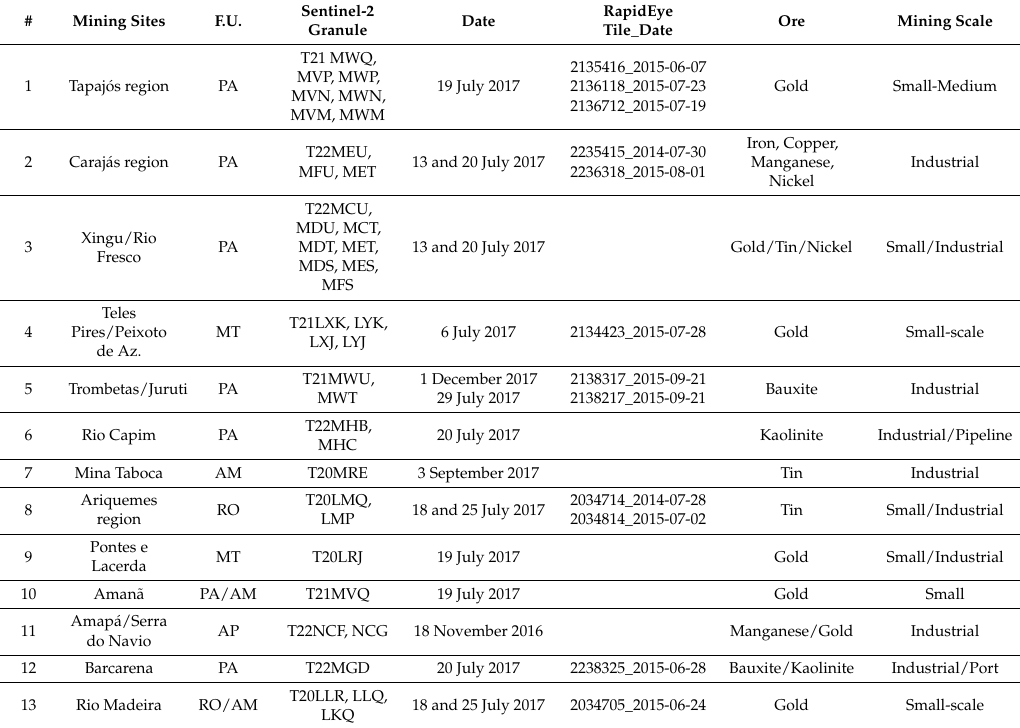
Table 1. Information of the mining sites regarding to location, Sentinel-2 tiles and acquisition date, ore exploited and mining scale. Mining scale varies from small-scale (“garimpos” with rudimentary techniques), medium (mines with improved techniques, pitloaders, cyanide tanks), industrial scale (large mining operations with high mechanization which can include ports, pipelines, ore refinery,